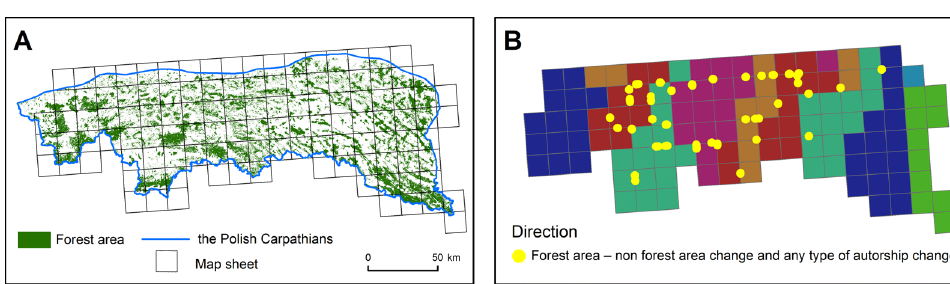
Fig. 7. Changes to the ‘forest – non forest’ category on the boundaries of the map sheets: study area with indicated forest areas (A), changes in regard to director change